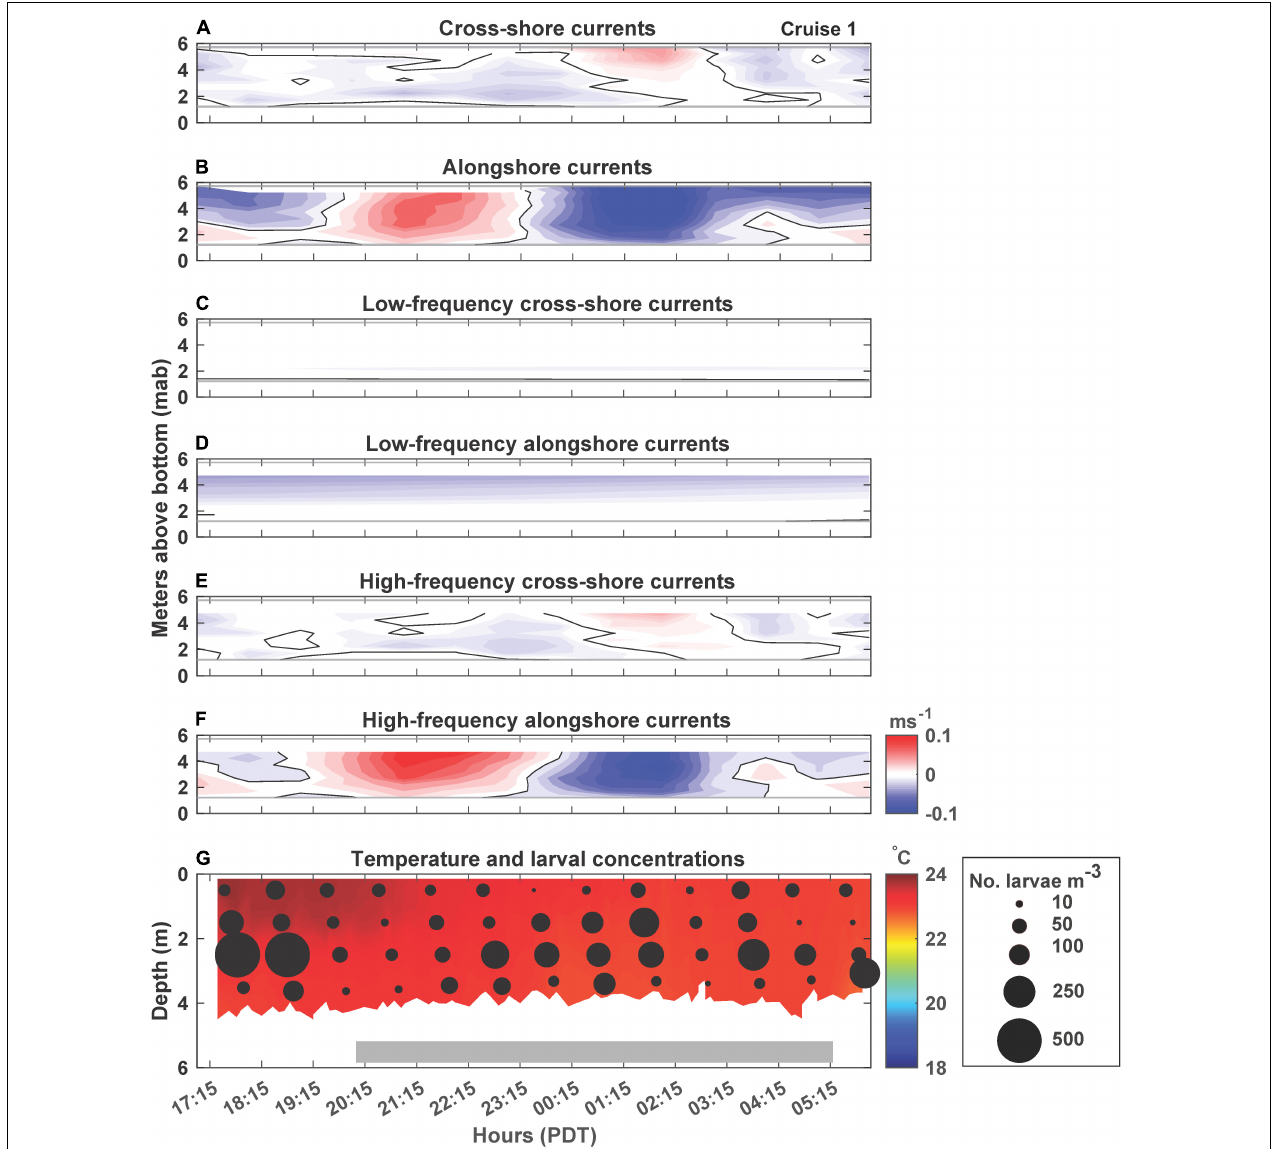
FIGURE 2 | Cruise 1 (July 16–17, 2017) currents, temperature and larval concentrations. Contour plots of hourly-averaged currents (ms − 1 ), with (A) unfiltered cross-shore ( u ) component (positive values corresponding to onshore or eastward flow), (B) unfiltered alongshore ( v ) component (positive values corresponding to southward flow), (C) low-frequency cross-shore component, (D) low-frequency alongshore component, (E) high-frequency cross-shore component, and (F) high-frequency alongshore component. The thin gray horizontal lines indicate the depths above and below which ADCP data are missing. The black lines indicate the 0 ms − 1 contours (G) temperature contour plot using CTD data at 4 m deep site with overlaid black circles representing Chthamalus fissus cyprid concentrations (no. m − 3 ) in each sampling depth bin for each hour of sampling. The white area below the contour plot shows the changing water depth due to the tides, and the filled gray rectangle represents night-time sampling. Hours are in Pacific Daylight Time